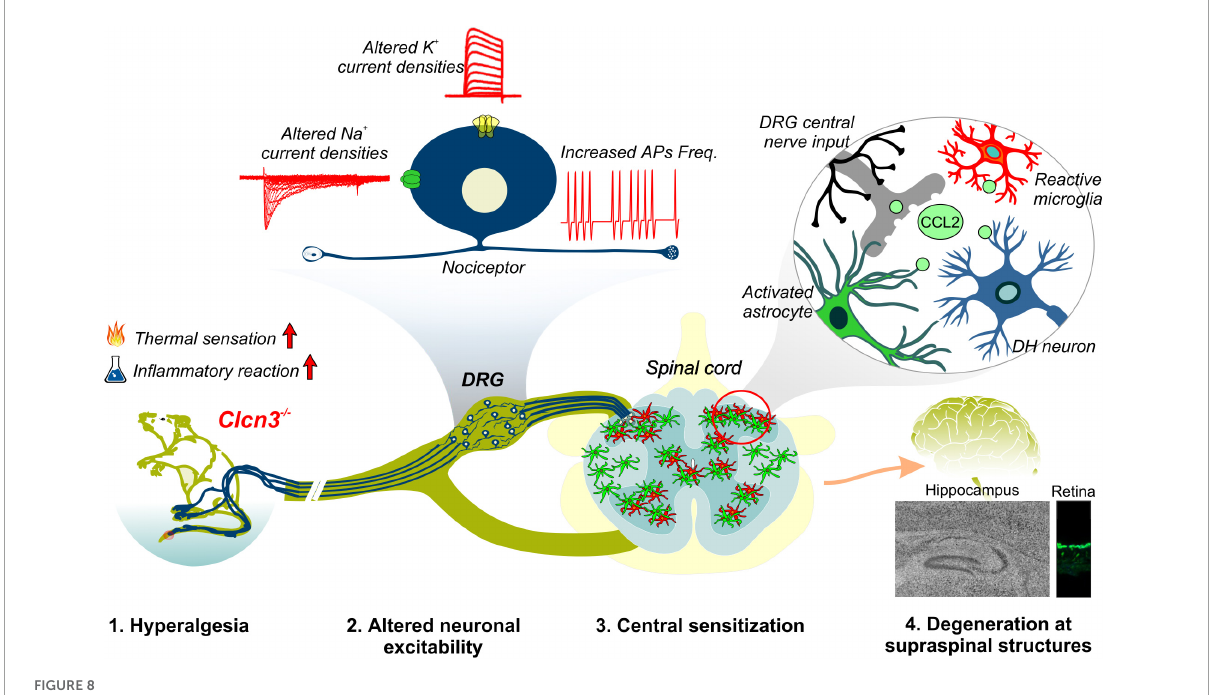
FIGURE8 Summary of phenotypic alterations in Clcn3 − / −